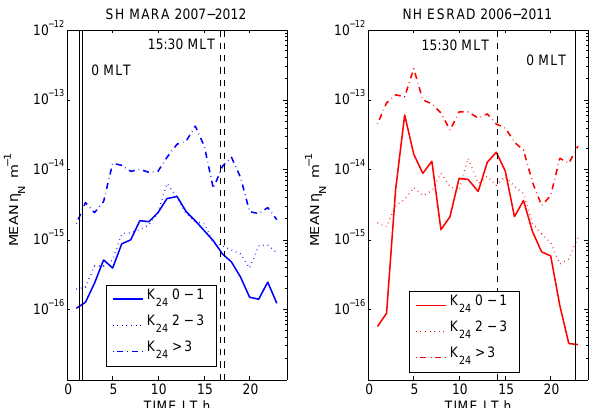
Fig. 7. Local-time dependence of mean PMSE volume reflectivity for different levels of magnetic disturbance. Means are based on 1-h averages, the months of June and July at ESRAD, December and January at MARA, with values below η N = 10 − 16 m − 1 set to zero. Averages are over heights 80–90km at ESRAD, 83–93km at MARA.